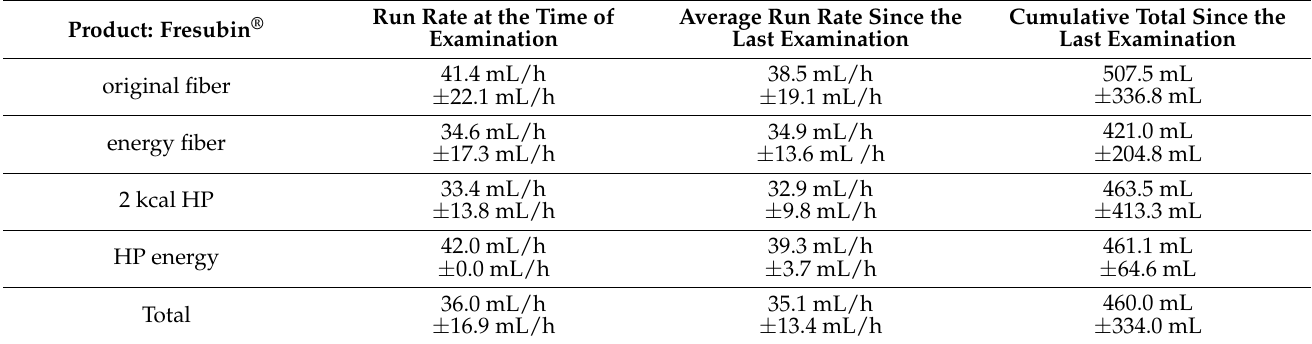
Table A2. Run rate of EN at the time of examination, average run rate since the last examination, and cumulative total since the last